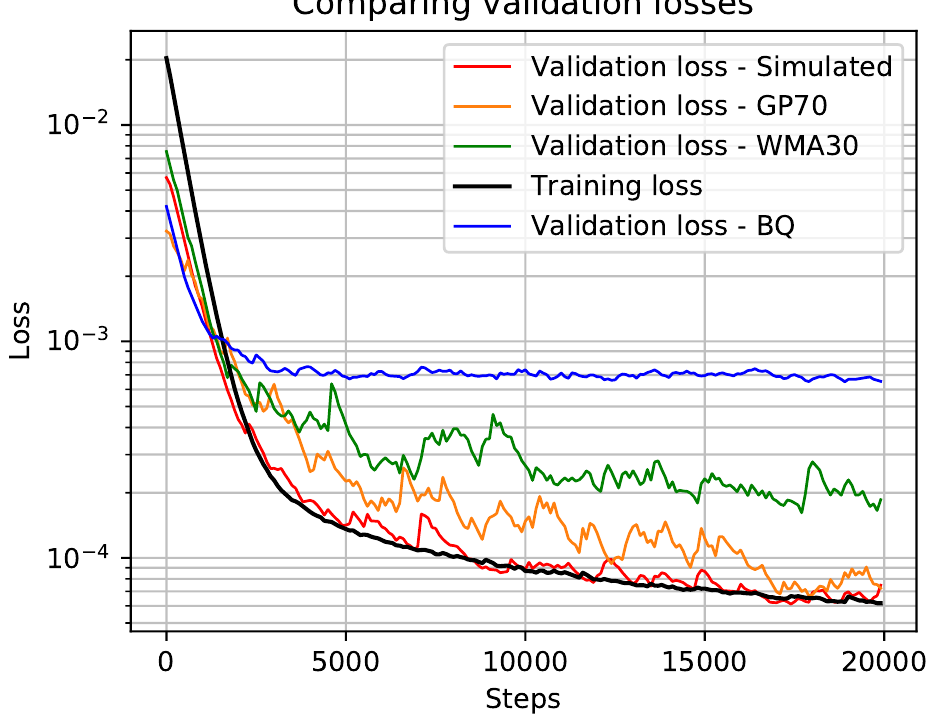
Figure 10. Comparison of validation losses when using simulated and real spectra respectively. Note that the dataset containing the real spectra was used to obtain tune estimates from BQ, GP70 and WMA30, thus creating 3 separate validation